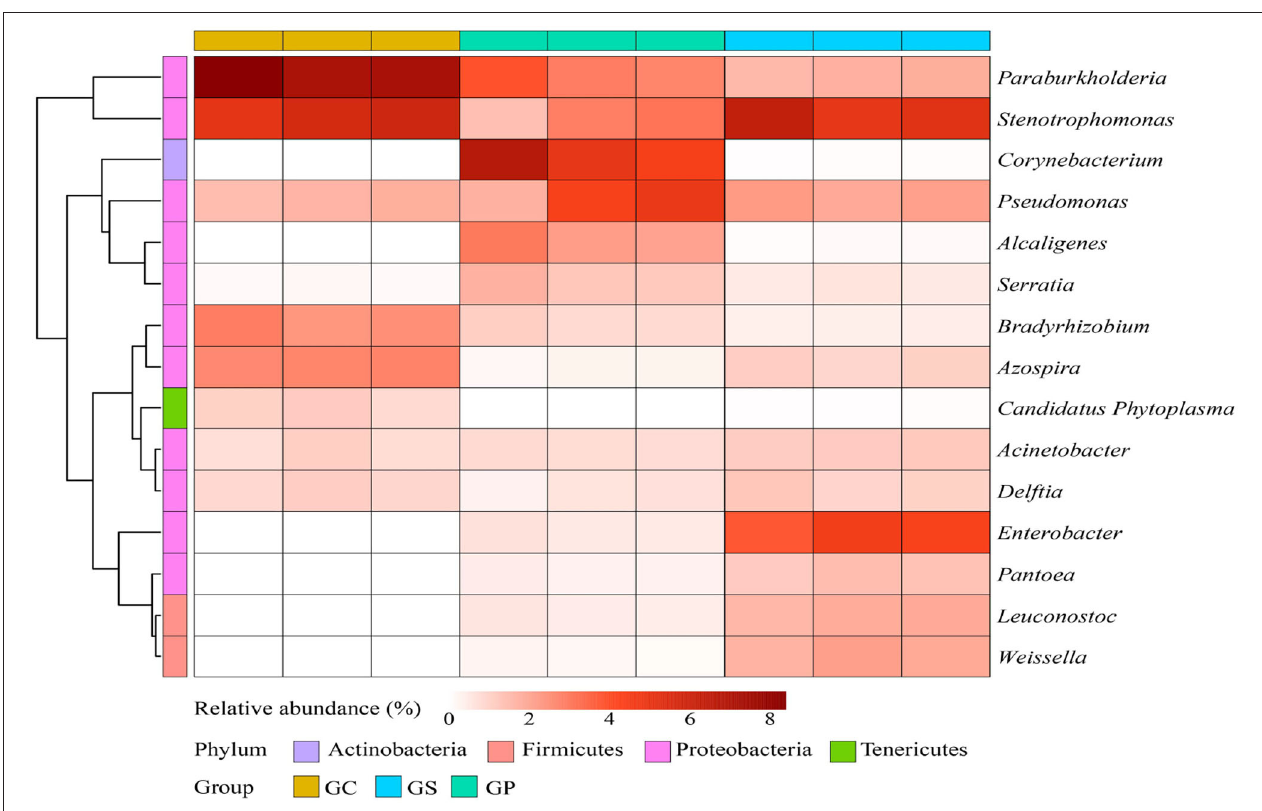
FIGURE 5 | Heatmap of the relative abundance of bacterial communities at phylum and genus levels during the garlic processing. Clustered at the gate level according to abundance and similarity.